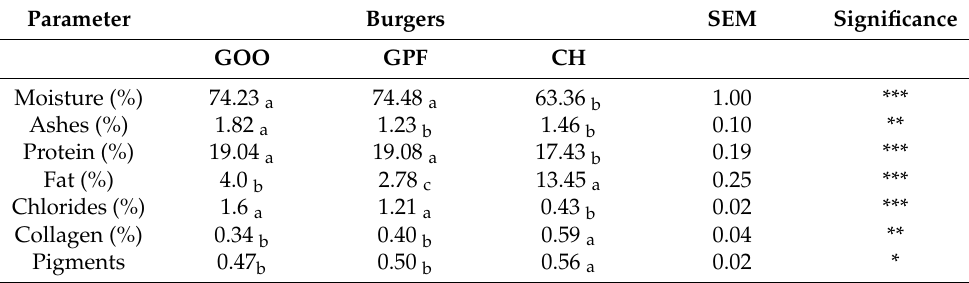
Table 3. Effects of fat replacement by olive oil on the physicochemical composition of goat burgers as compared with commercial beef